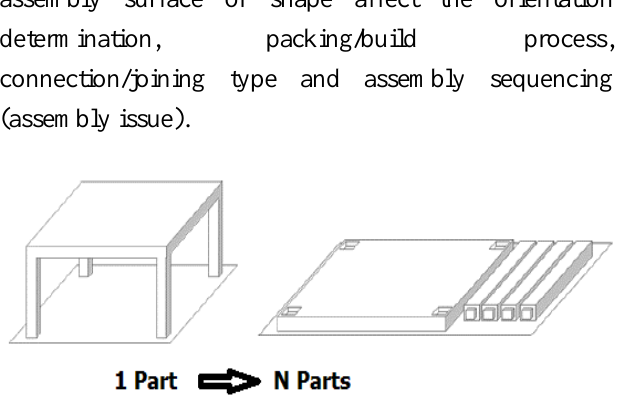
Fig. 2. Part decomposition